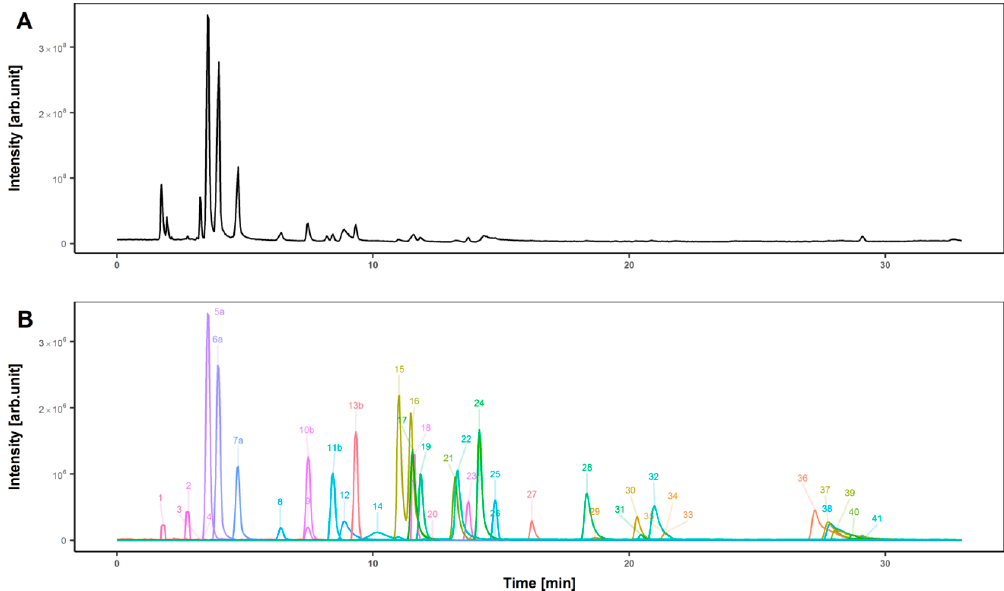
Figure 2. Total ion chromatogram ( A ) of measured reference material with Orbitrap Velos Pro (Thermo). Separation was performed with BEH amide (2.1 mm × 150 mm particle size 1.7 µ m) at 40 ◦ C. ( B ) Extracted ion chromatograms (EICs) of identified purchased standards. All standards were injected